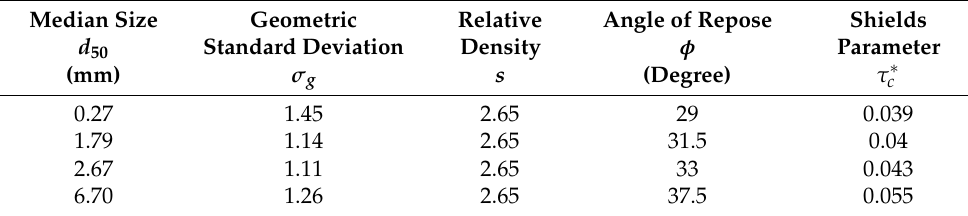
Table 1. Sediment properties used in the tests are displayed.